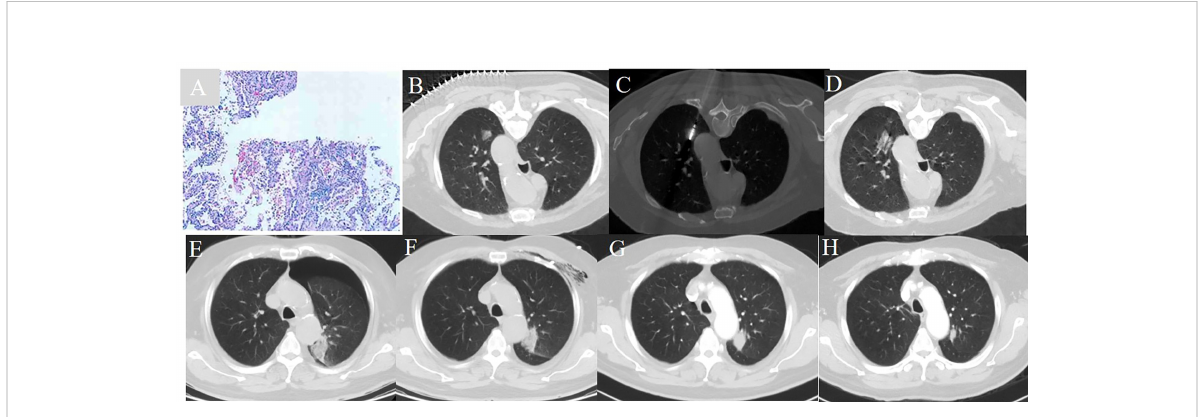
FIGURE 1 A 72 year-old man with a history of COPD and a FEV1 value of 51.2% underwent CT guided microwave ablation after pathological diagnosis of adenocarcinoma in situ. (A) Pathology veri fi ed adenocarcinoma in situ. (B) A ground glass nodule with a diameter of 1.7 cm located in the left upper lobe. (C) MWA was conducted with the power of 65 W for a total of 4.5 min. (D) The immediate CT scan showed the nodule was surpassed by the exudative change. (E) A CT scan showed moderate pneumothorax 24 hours post-ablation. (F) Pneumothorax was resolved 72 hours post-ablation. (G) The ablative zone shrank and increased in density one month post-ablation. (H) The CT ablative zone further reduced one year